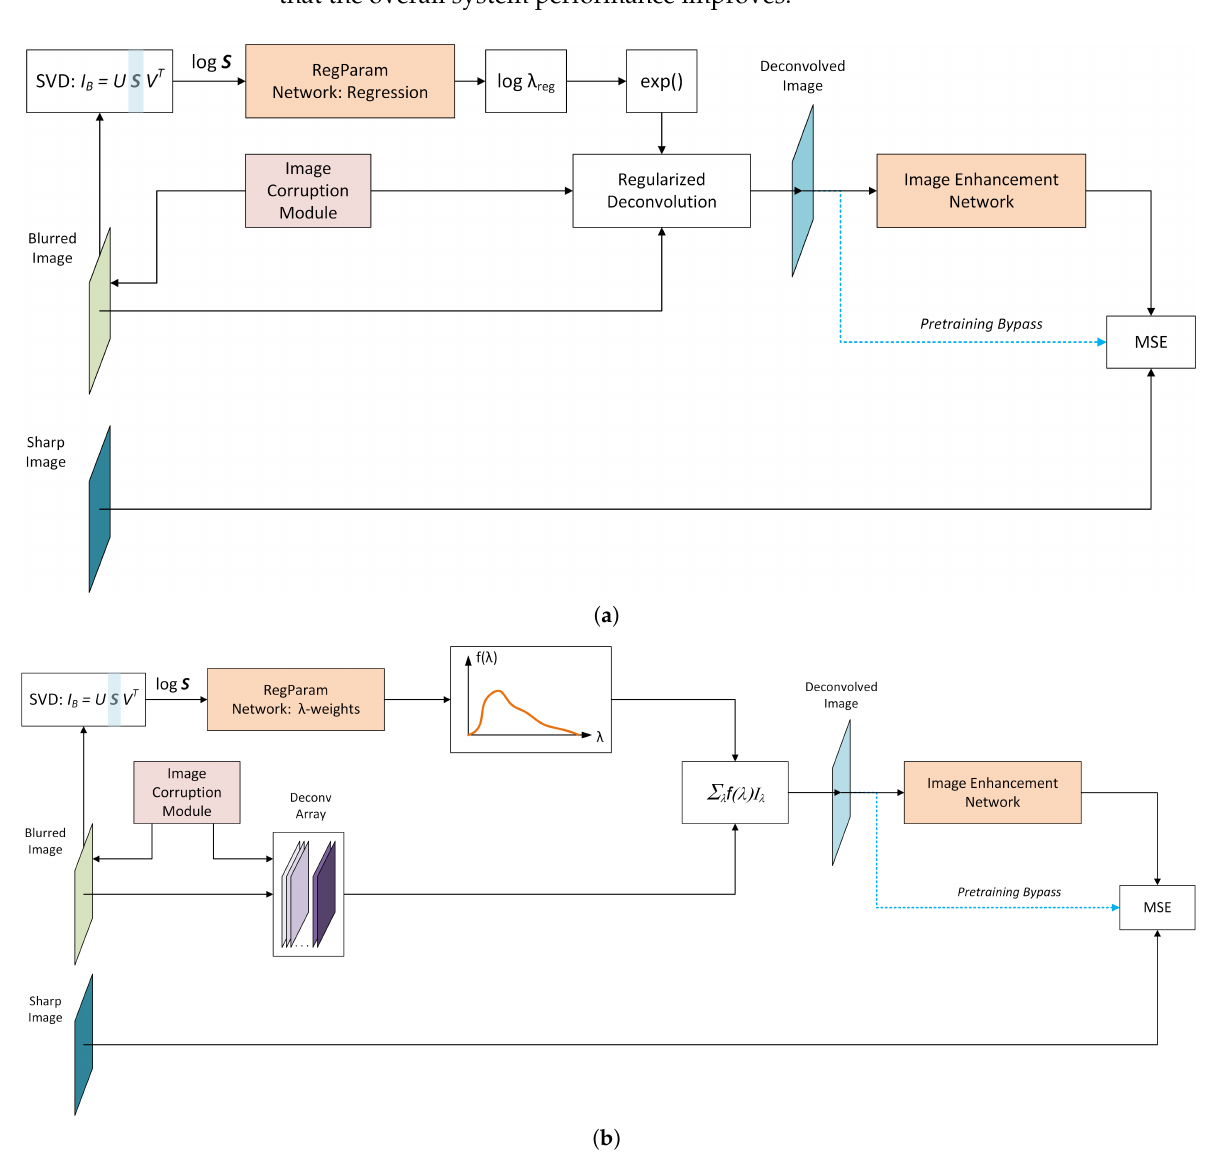
Figure 13. E2E system training schemes: ( a ) Regression RegParamNet; ( b ) λ -weight